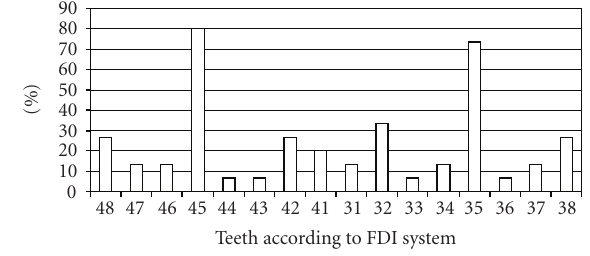
Figure 10: Frequency of agenesis of permanent lower teeth in 15 patients with ARS and